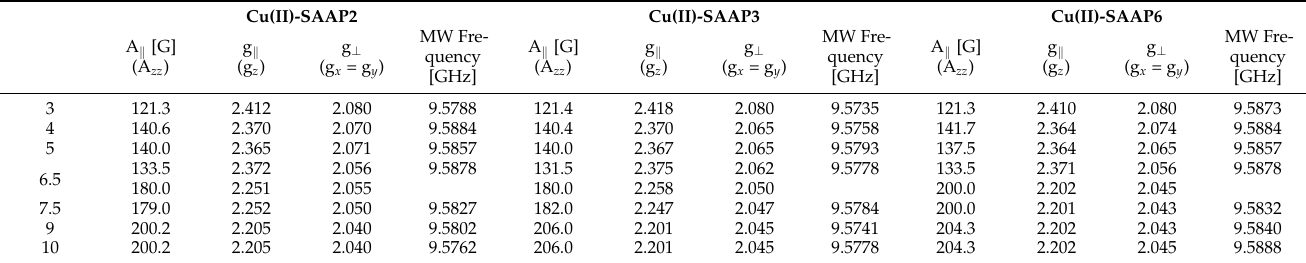
Table 2. EPR spectral parameters at different pH values obtained from X-band EPR spectra of frozen solutions (77 K) of 1 mM Cu(II)-SAAP2, Cu(II)-SAAP3, and Cu(II)-SAAP6 (1:1 Cu(II)-to-peptide molar ratio). Samples were in aqueous solutions with 4 mM HClO 4 and 0.1 M NaClO 4 and 30% ethylene glycol. Parameters marked in gray at pH 6.5 correspond to two overlapped different complex